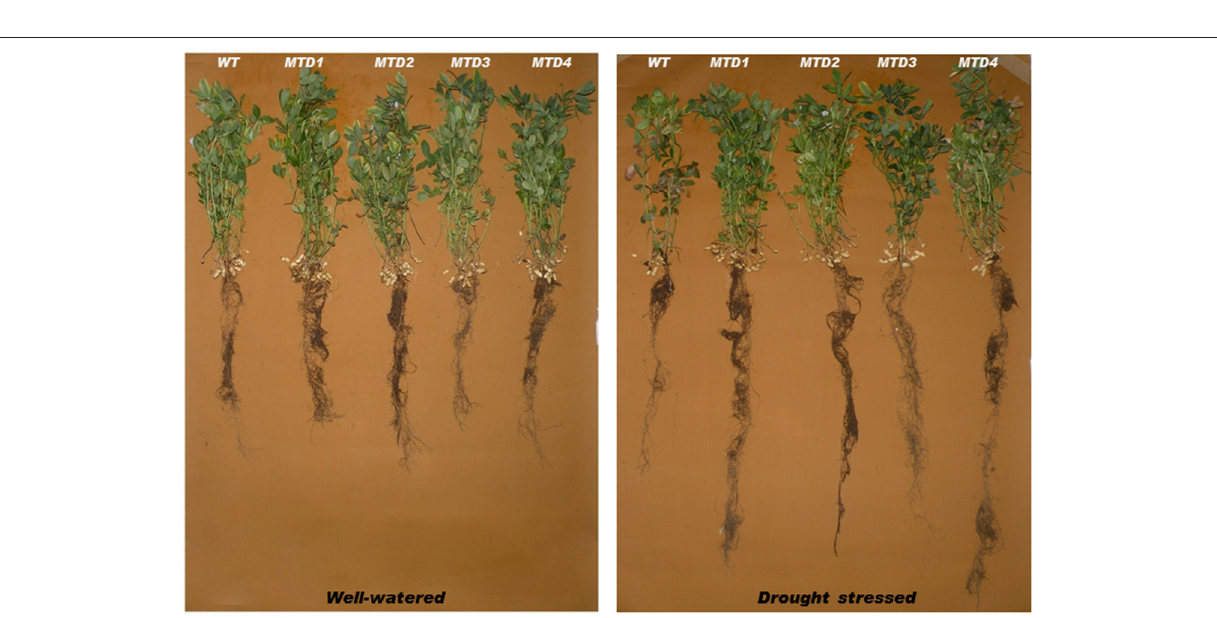
Frontiers in Plant Science |